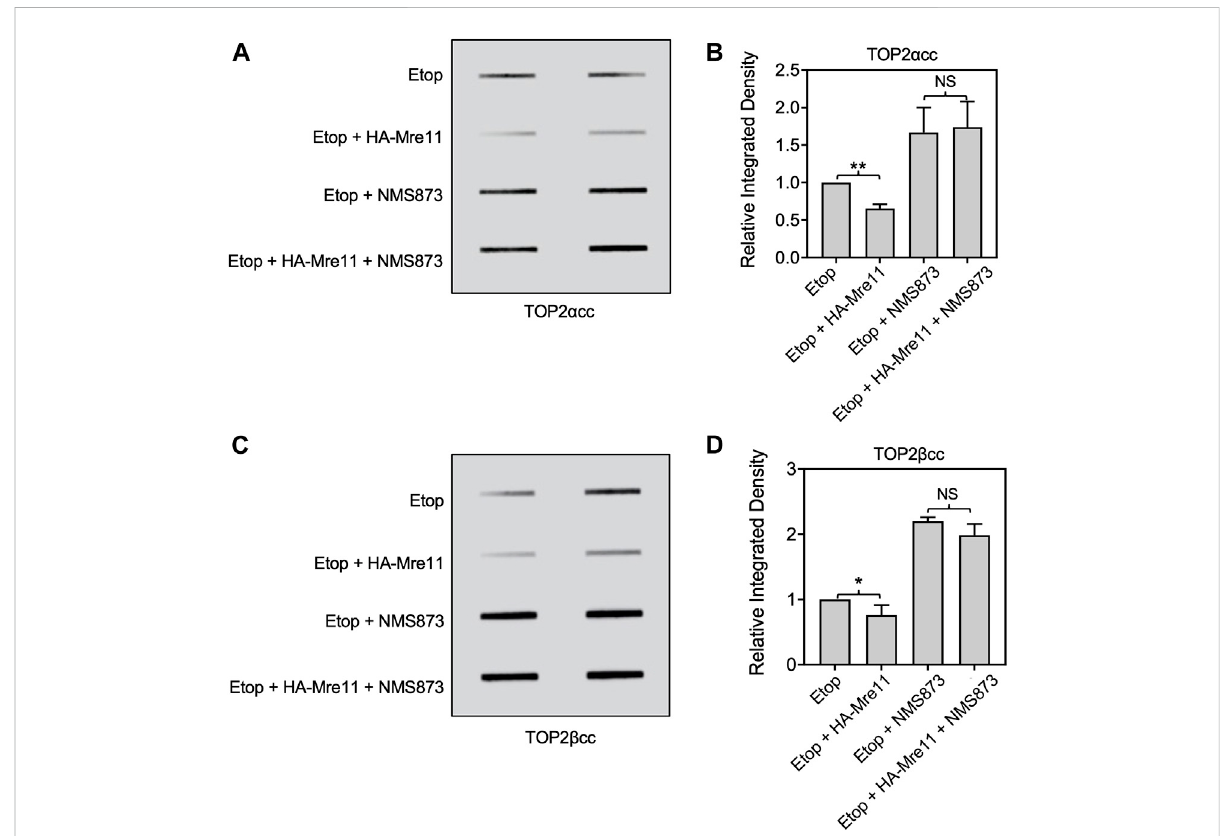
FIGURE 8 Inhibition of VCP/p97 prevents processing by ectopic expression of MRE11. HEK293 cells were transfected with HA-MRE11 overexpressing plasmid for 48 h prior to treatment with 10 μ M NMS873 1 h. Etoposide (10 μ M) was added, and incubation was continued for 1 h before ICE assays. (A) Representative ICE assay measuring the levels of TOP2 α cc. (B) Densitometric analysis of all assays comparing relative integrated densities of TOP2 α cc signals. Integrated density of TOP2 α cc signal of each group was normalized to that of control cells (no transfection) treated